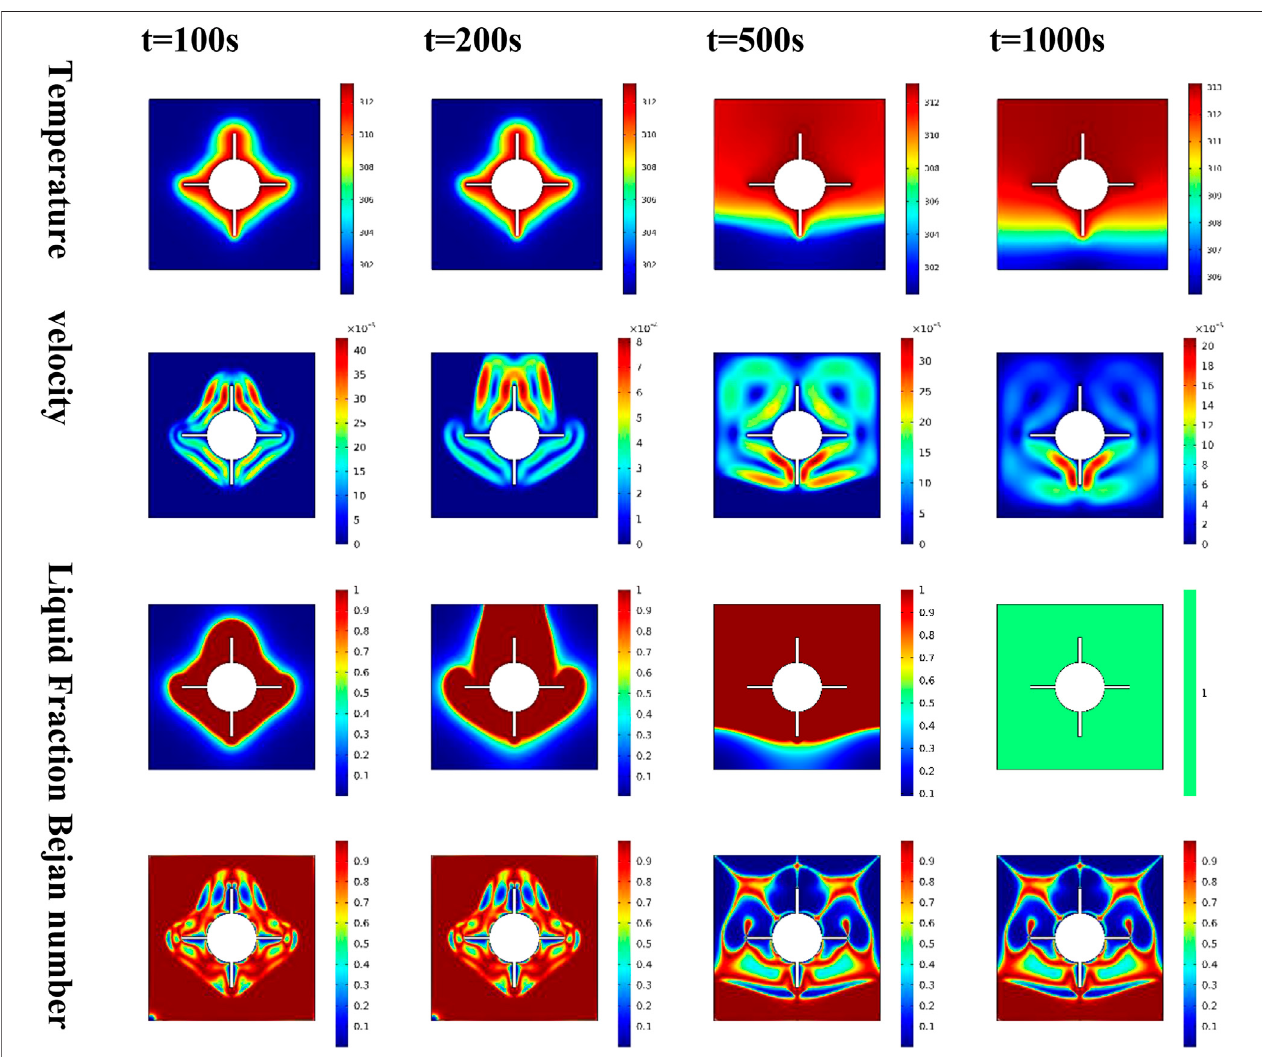
FIGURE 5 | Variations of temperature, liquid fraction, and Bejan number during. the PCM melting process as time goes on when ϕ (cid:1) 0 .